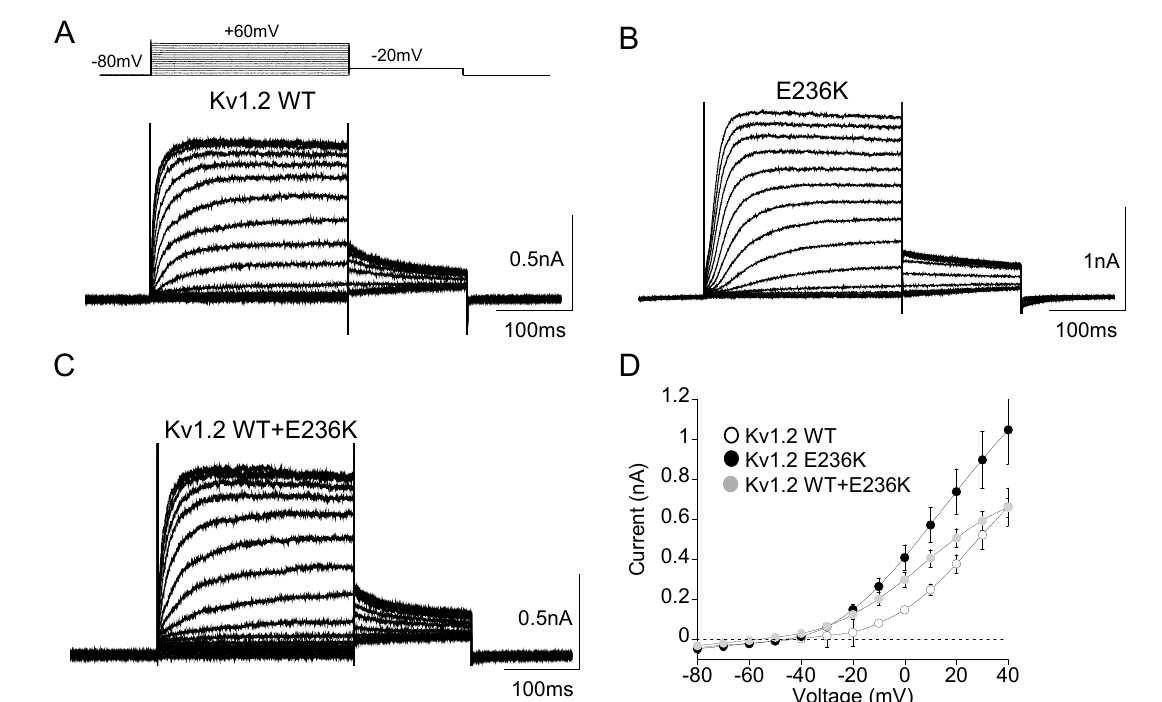
Figure 3. ( A – C) Representative current traces evoked by 200 ms depolarizing steps from a holding potential of − 80 to +60 mV from Kv1.2 WT ( A ), E236K ( B ), and Kv1.2 WT+E236K ( C ) channels expressed in HEK293 cells. The voltage protocol is indicated in the upper panel in ( A ). ( D ) Current–voltage relationship for Kv1.2 WT (7 µ g), E236K (7 µ g), and Kv1.2 WT+E236K (3.5 + 3.5 µ g) channels ( n = 14–36). Table 1. Biophysical parameters of Kv1.2 WT (7 μ g), E236K (7 μ g) and Kv1.2 WT+E236K (3.5 + 3.5 μ g) channels expressed in HEK 293 cells.